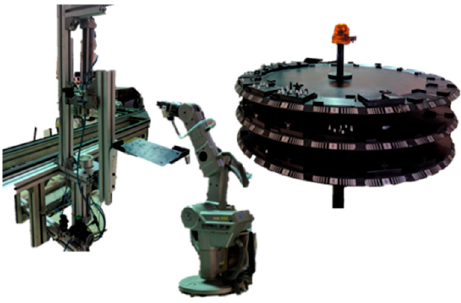
Figure 11. Assembly setup with pneumatic cylinders, the robotic arm, and the storage tower.